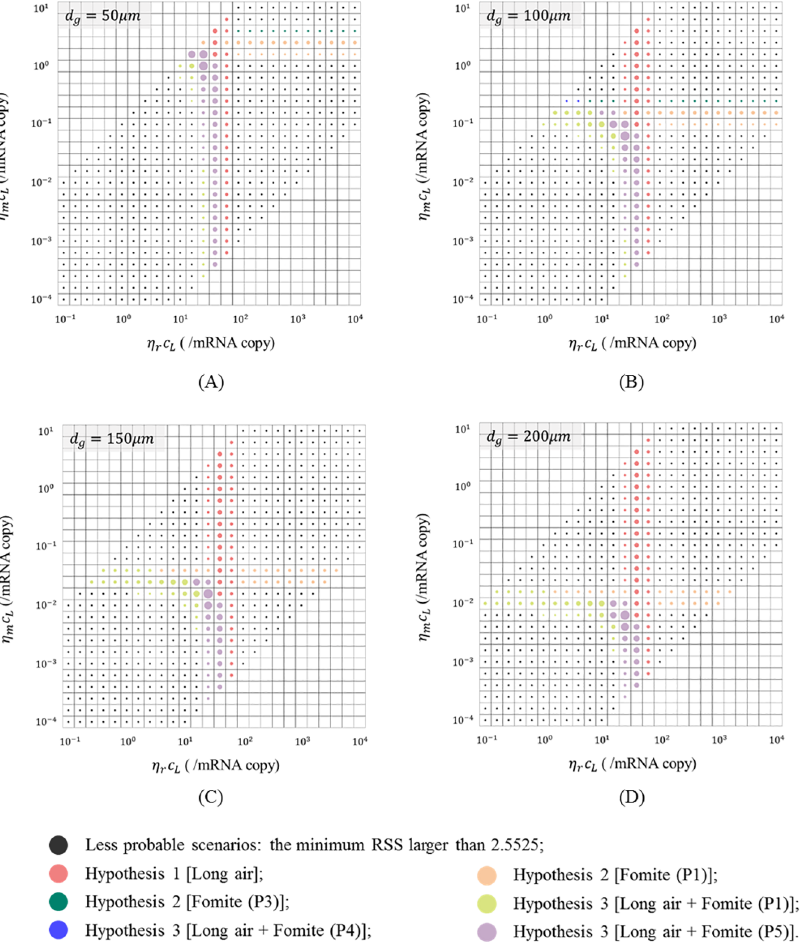
Fig 4. Illustration of the hypotheses with the minimum RSS in 1,744 scenarios. d g denotesthe largest virus-containing droplet size (4 values: 50, 100, 150 and 200 μ m); η r c L and η m c L denoteproducts of viral load coefficient and dose–response parametersin respiratory tracts (26 values, 10 − 1 –10 4 /mRNA copy) and on mucous membranes (26 values, 10 − 4 –10 1 /mRNA copy). (A) d g = 50 μ m; (B) d g = 100 μ m; (C) d g = 150 μ m; (D) d g = 200 μ m. Dots of different colours represent different hypothesesas shown in the legend.Dot diameter is inverselyproportionto the value of RSS. The smallest RSS in all scenarios(the biggestdot) was 0.5505, and the small black dots represent scenarioswith the minimum RSS at least five times as much as 0.5505.